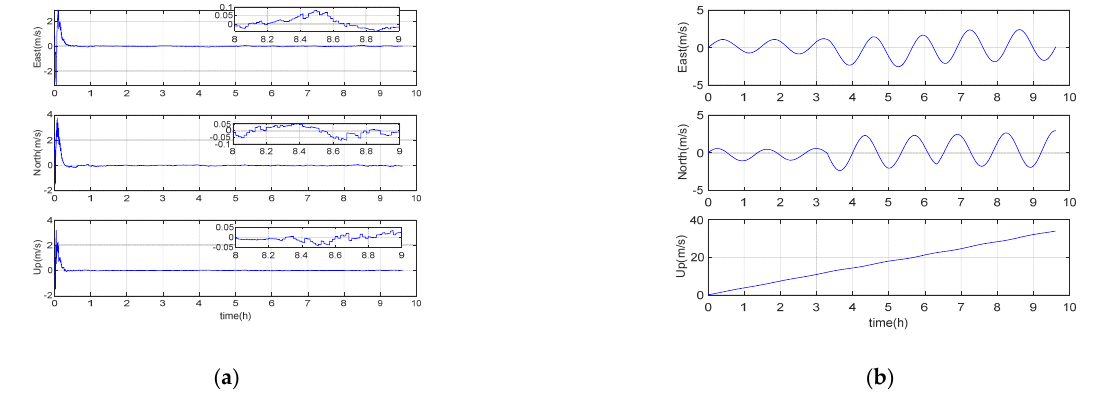
Figure 2. ( a ) GGAN speed error; ( b ) pure inertial calculation speed error.